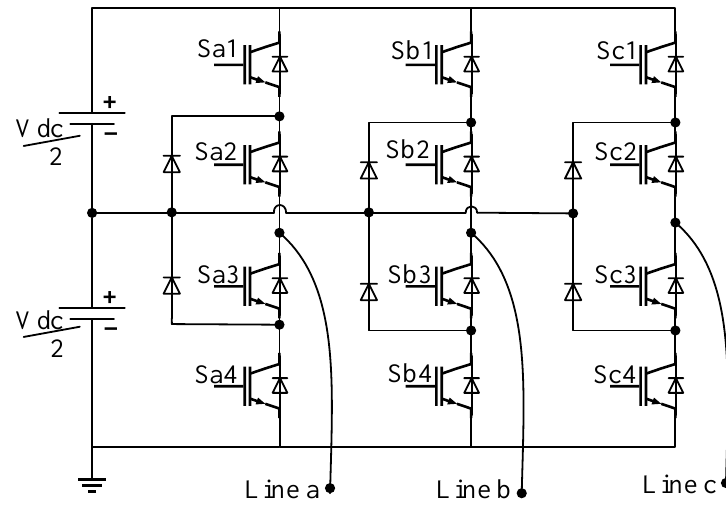
Figure 2. The structure of a general three-level (3L) inverter.